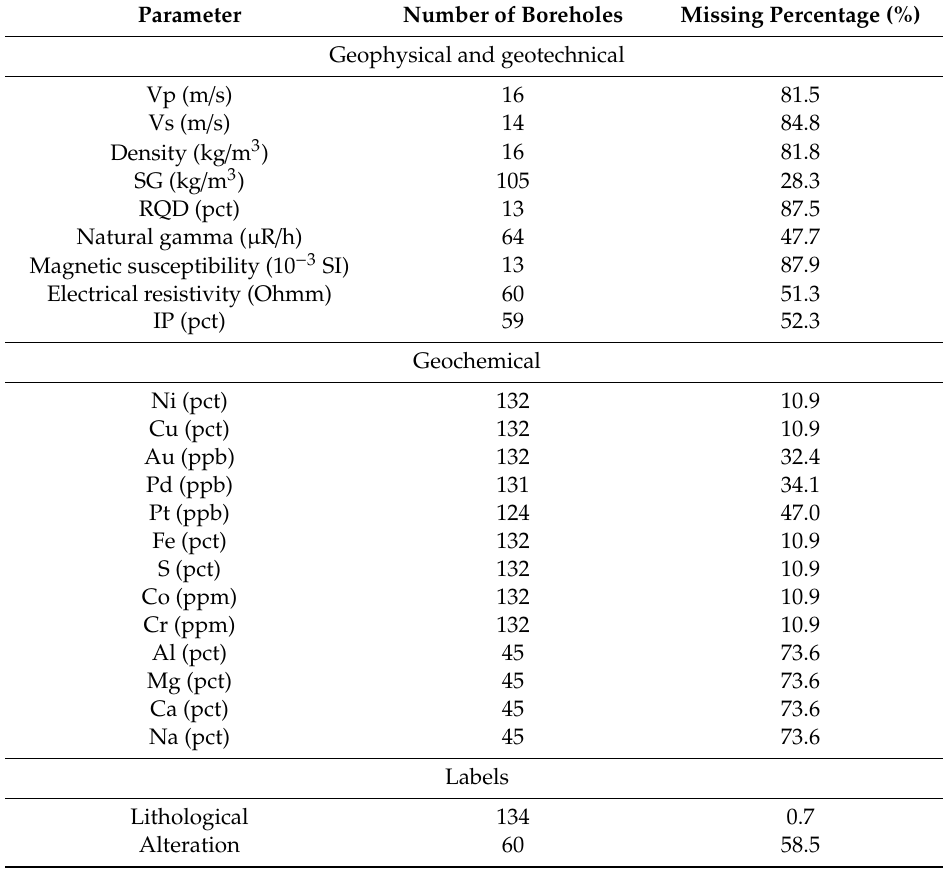
Table 1. Di ff erent parameters used in SOM. In total 134 boreholes were selected for the SOM analysis. Listed in the table are the parameter (unit in brackets) and the number indicating from how many boreholes these parameters were available. In addition, the missing percentage was calculated for each parameter. The missing percentage is the percentage of samples with missing measurements for the given parameter out of the total amount of samples